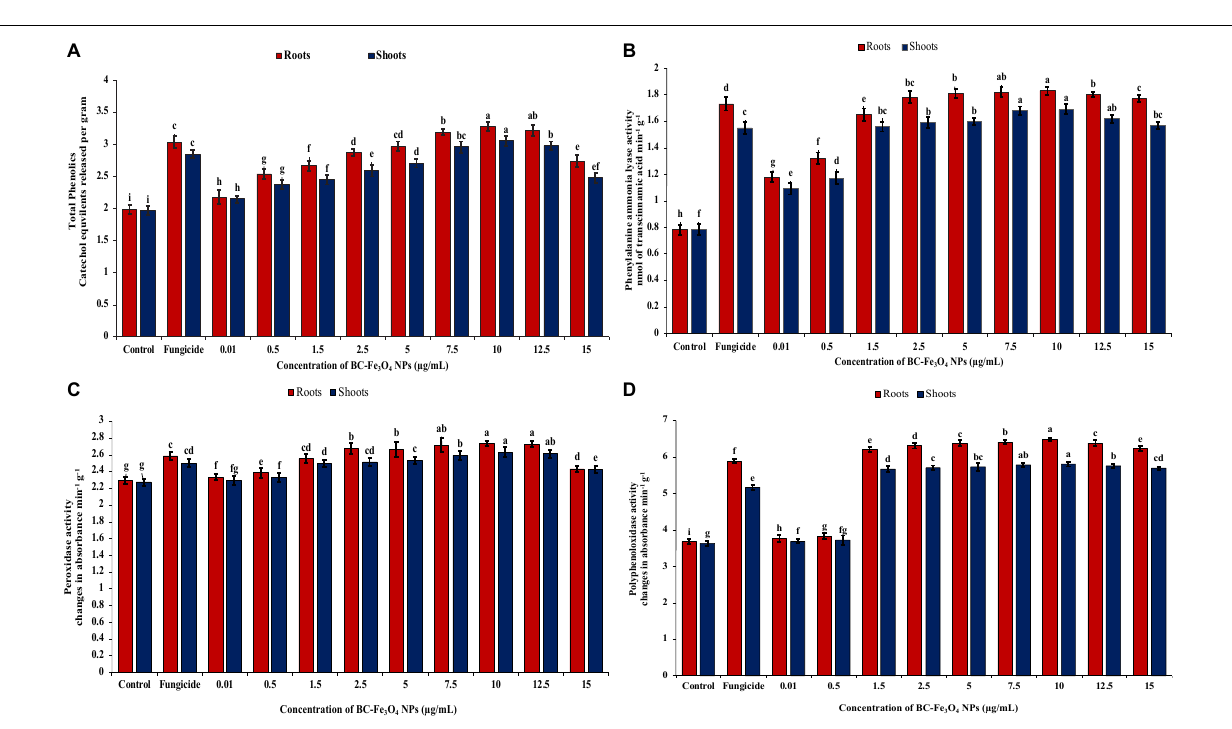
FIGURE 14 | Activities of phenolics and defense enzymes (PAL, POD, and PPO) in roots and shoots of tomato plants treated with different concentrations of BC-Fe 3 O 4 NPs. (A) Phenolic content, (B) phenylalanine-ammonia-lyase activity (PAL), (C) POD activity, (D) polyphenol-oxidase activity (PPO). Vertical bars represent SD ( n = 3) between the mean of different replicates of the same treatment. Different letters per column indicate significant differences among treatments, determined by the ANOVA and LSD-test at P ≤